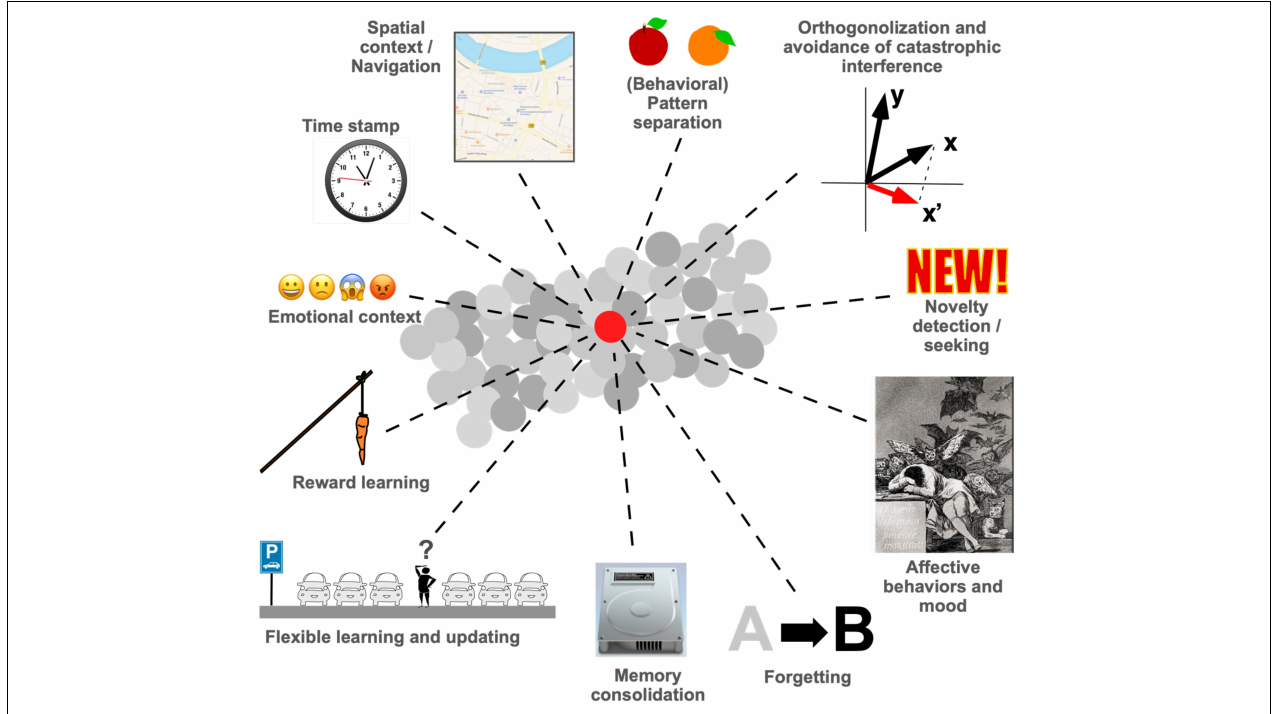
FIGURE 1 | Proposed functions of adult hippocampal neurogenesis in learning and memory as well as in affective behaviors. This list is not exhaustive, but the field is now at a point, at which many of the proposed functions converge. Forgetting and memory consolidation, for example, are clearly related, and so are pattern separation and orthogonalization. We have not yet achieved a unifying theory for all or most of these ideas, but much progress has been made. This article discusses some of the avenues that the field might take to obtain a more integrative view on what new neurons in the hippocampus are good